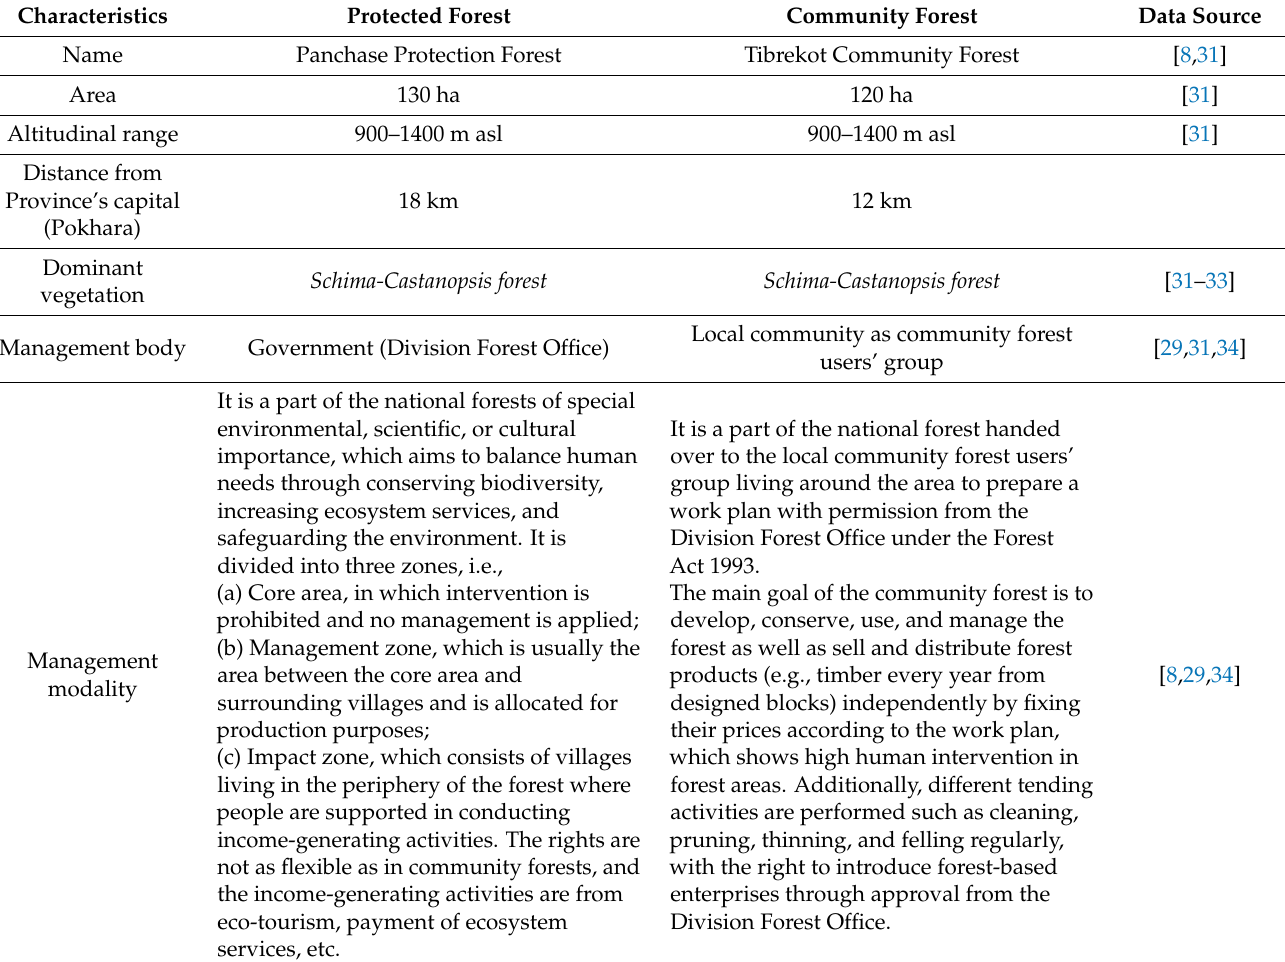
Table 1. Description of the study